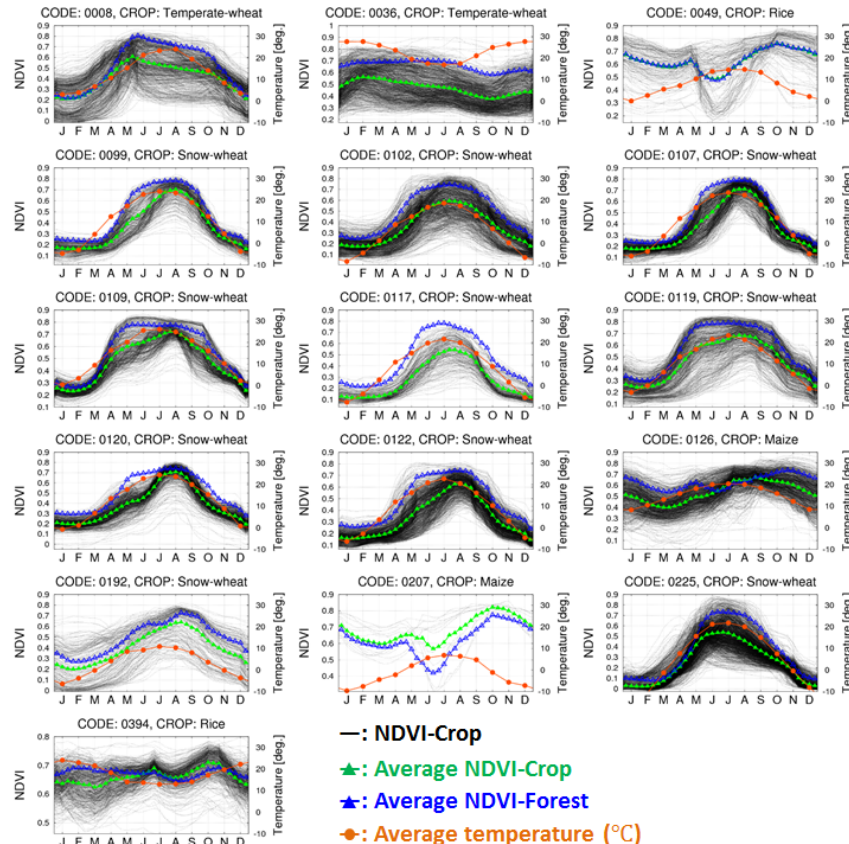
Figure 11. Time series of NDVI-Crop (black lines), average NDVI-Crop (green lines), average NDVI-Forest (blue lines), and average temperature (orange lines; ◦ C) in the 16 administrative units in Table 5; Azerbaijan (code 8), Australia Queensland (code 36), Bhutan (code 49), China Beijing (code 99), China Gansu (code 102), China Hebei (code 107), China Henan (code 109), China Ningxia (code 117), China Shaanxi (code 119), China Shandong (code 120), China Shanxi (code 122), China Yunnan (code 126), India Himachal Pradesh (code 192), India Sikkim (code 207), Kazakhstan (code 225), and Uruguay (code 394). The average denotes the average over the administrative